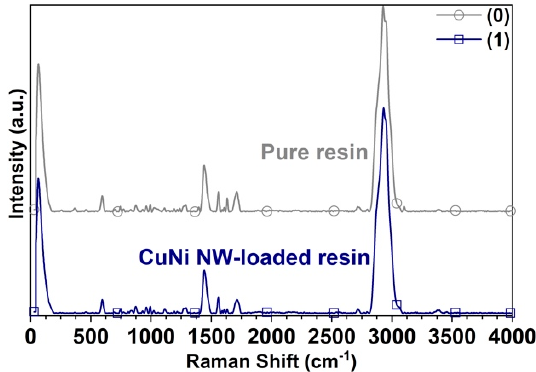
Figure 8. Raman spectra acquired on the substrates printed with (0) pure resin and (1) CuNi NW-loaded resin.